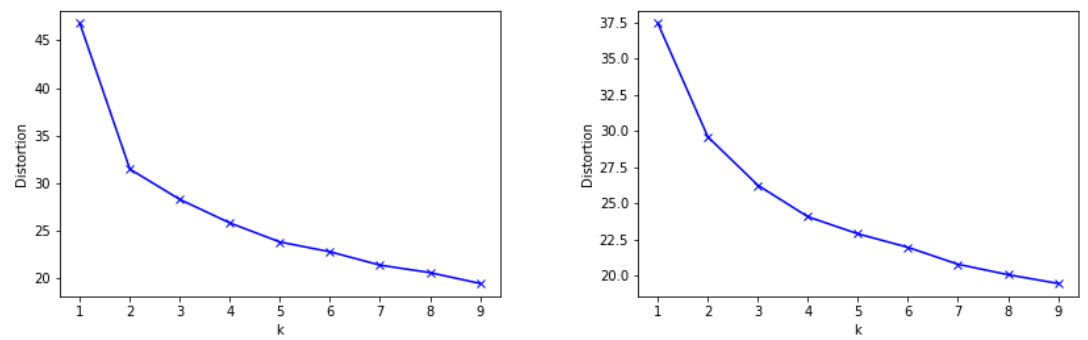
Figure 3. Result of the Elbow method for Valencia ( left ) and Berlin ( right